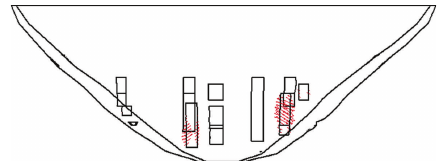
Figure 17: Distribution of cracks unbalanced force under overload 2.0𝑃 0 in scheme 2.